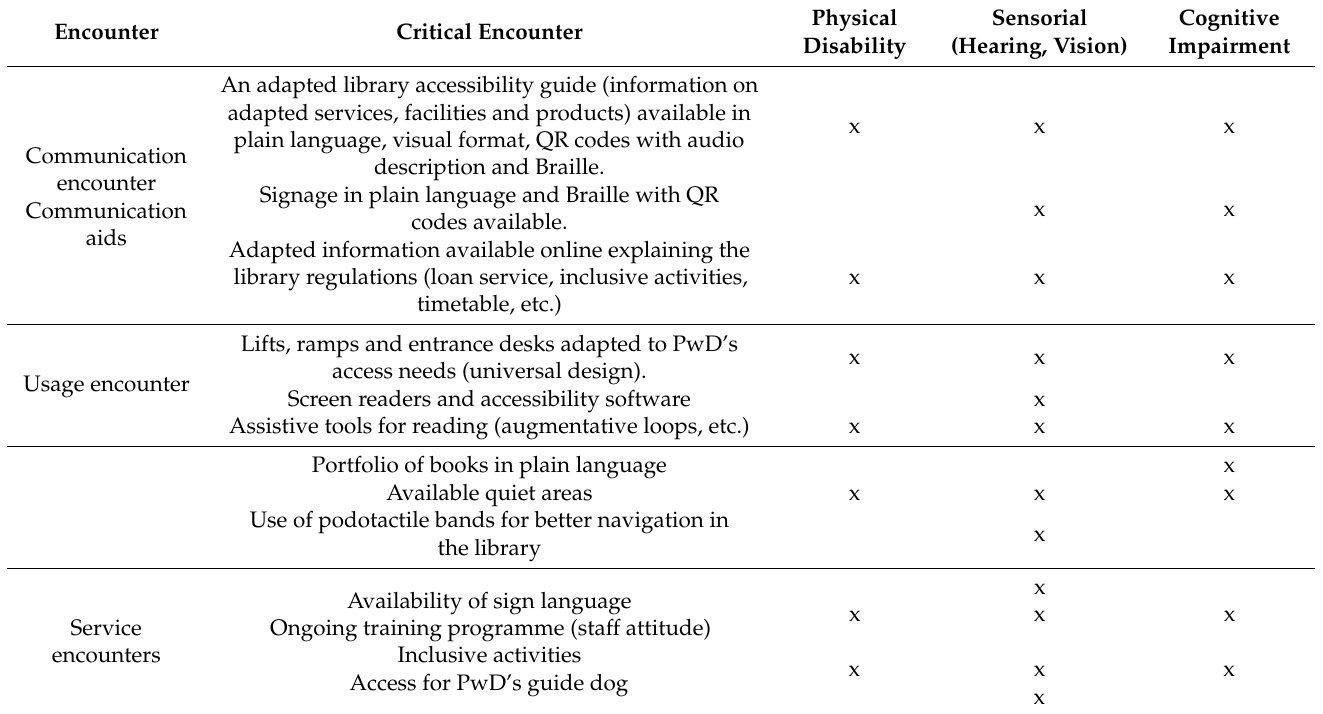
Table 3. Critical features of the